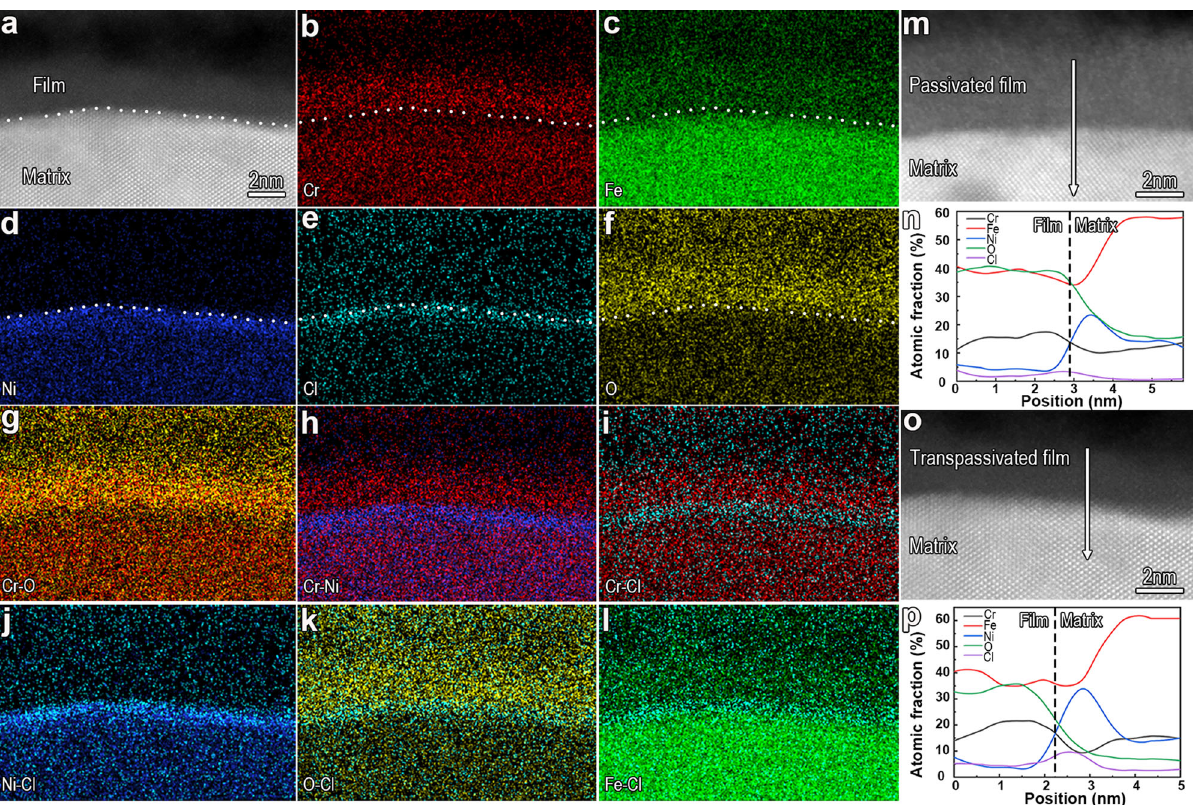
Fig. 8 Chloride ions incorporated in and penetrating the transpassive fi lm, as well as accumulating at the metal side of the matrix/transpassive fi lm (Me/TF) interface. a HRHAADF-STEM image along the [110] matrix direction showing a sharp Me/TF interface. The transpassive fi lm was immersed